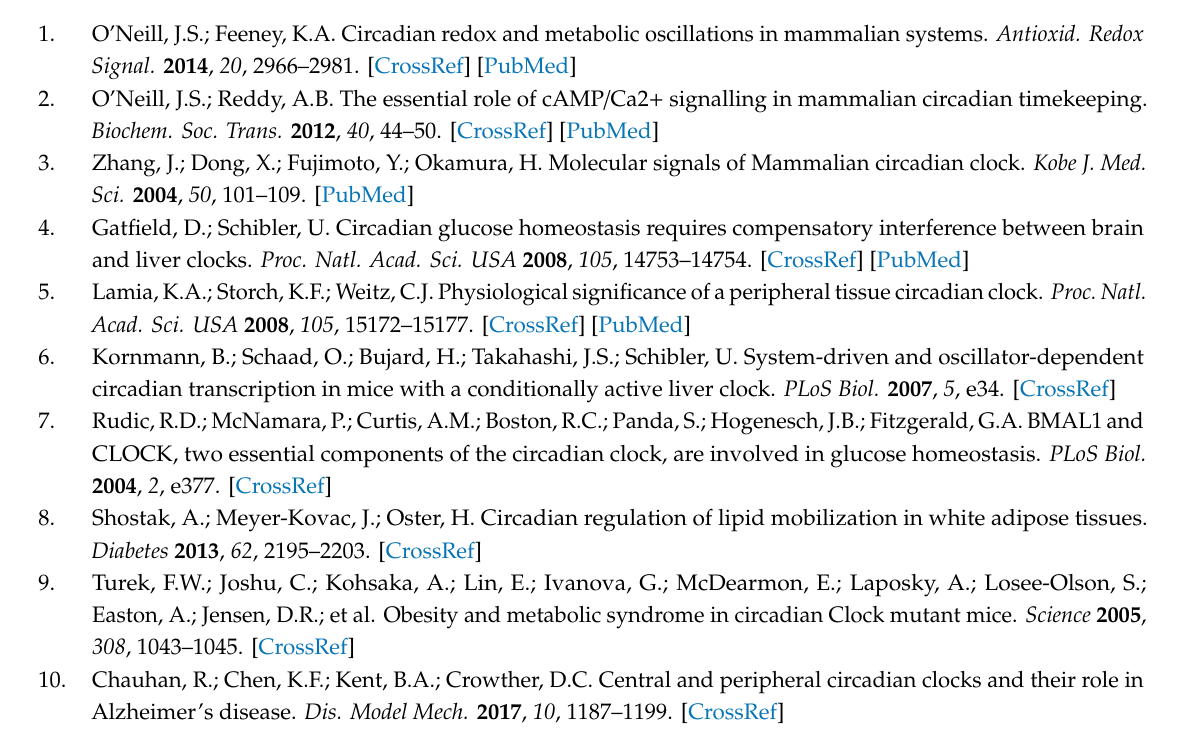
Table S1: Preferred Reporting Items for Systematic Reviews and Meta-Analyses (PRISMA) checklist, Table S2: Electronic search strategy, Table S3: Summary of two studies excluded in the present meta-analysis, Figure S1: Funnel plots, Figure S2: Sensitivity